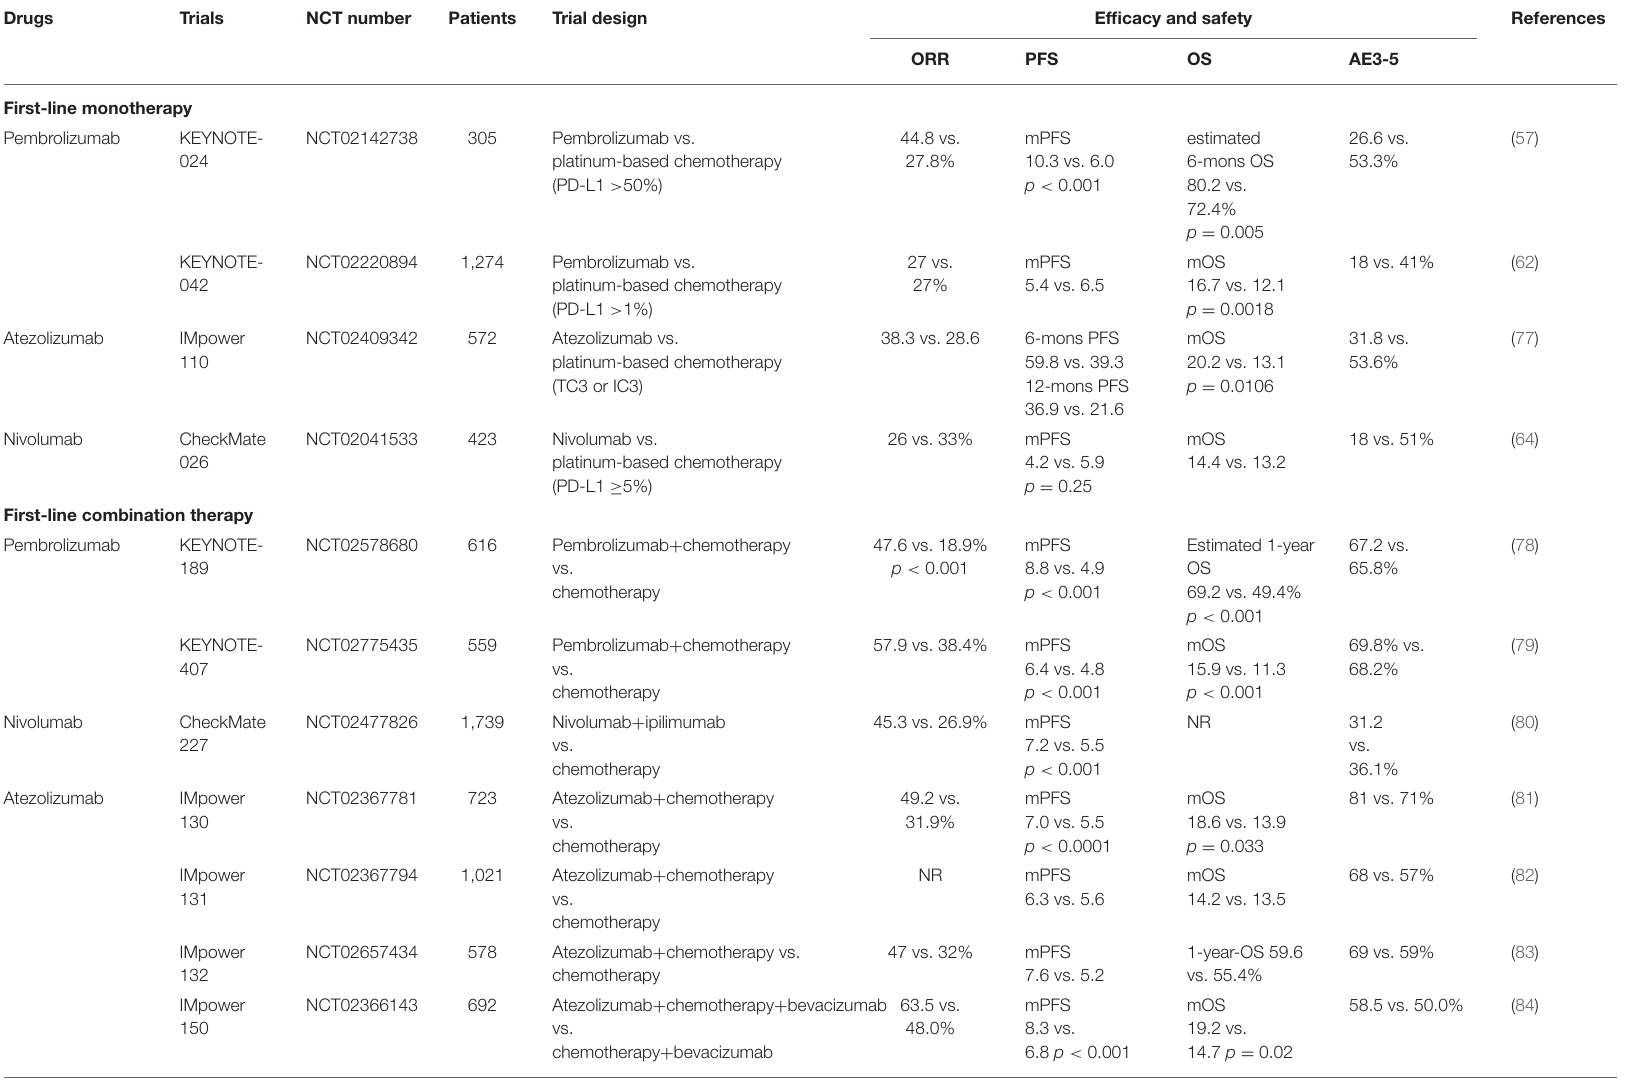
TABLE 3 | The results of recent advances in landmark trials of different PD-1/PD-L1 inhibitors for the treatment of lung cancer.